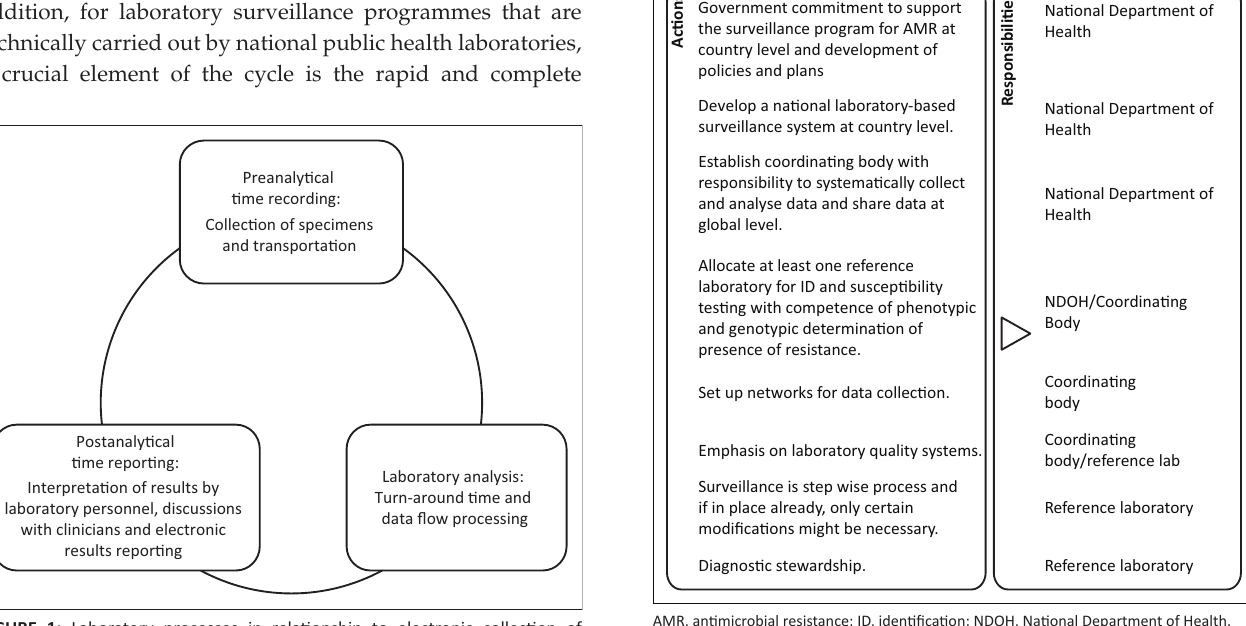
FIGURE 1: Laboratory processes in relationship to electronic collection of antimicrobial resistance data. FIGURE 2: Surveillance programme